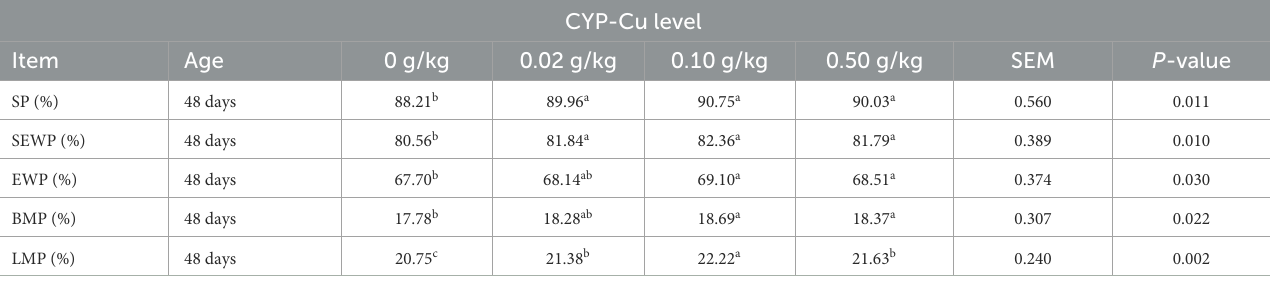
TABLE 4 Effect of dietary CYP-Cu on the carcass performance in broilers on day 48.